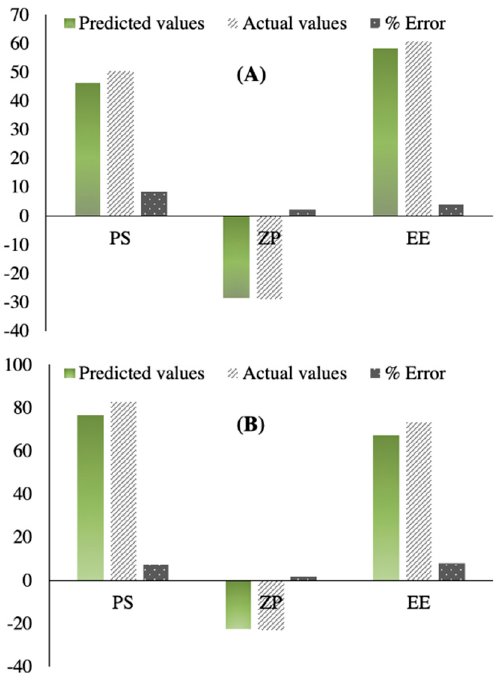
Figure 5. The correlation between the predicted and the actual values of the particle size, zeta potential, and entrapment efficiency of OFM ( A ) and OFA ( B ).